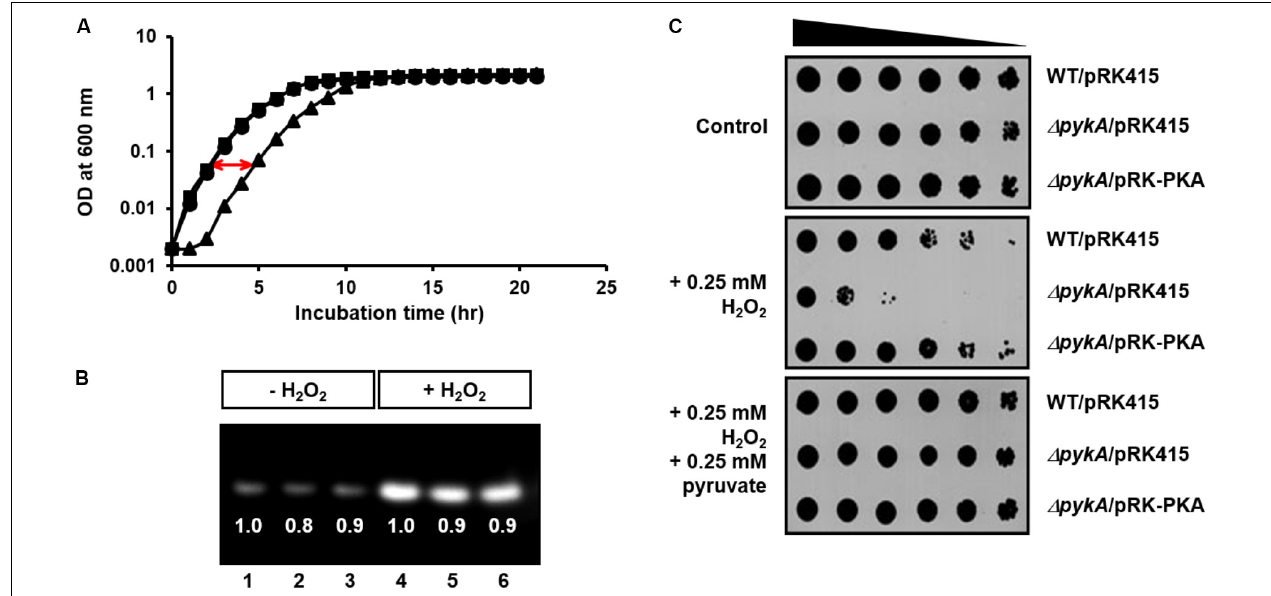
FIGURE 2 | Effects of PykA activity and pyruvate on resistance of V. vulnificus to H 2 O 2 stress. (A) Growth curves of wild-type CMCP6 (squares), pykA mutant (triangles) and complemented ( pykA /pRK-PKA, circles) strains in LB supplemented with 2.5% NaCl (LBS medium) in the presence of 0.8 mM H 2 O 2 . (B) The relative expression levels of catalase in wild-type CMCP6 (lanes 1 and 4), pykA mutant (lanes 2 and 5) and the complemented strains (lanes 3 and 6) in LBS medium in the presence and absence of 0.8 mM H 2 O 2 . Same amounts of proteins in cell lysates were loaded in each lane. (C) Stationary-phase cells of the indicated V. vulnificus strains were serially diluted fourfold from 0.25 × 10 8 cells/ml and 2- µ l aliquots were spotted onto LBS medium containing different combinations of H 2 O 2 and sodium pyruvate as indicated. Representative data from at least three independent experiments are presented.